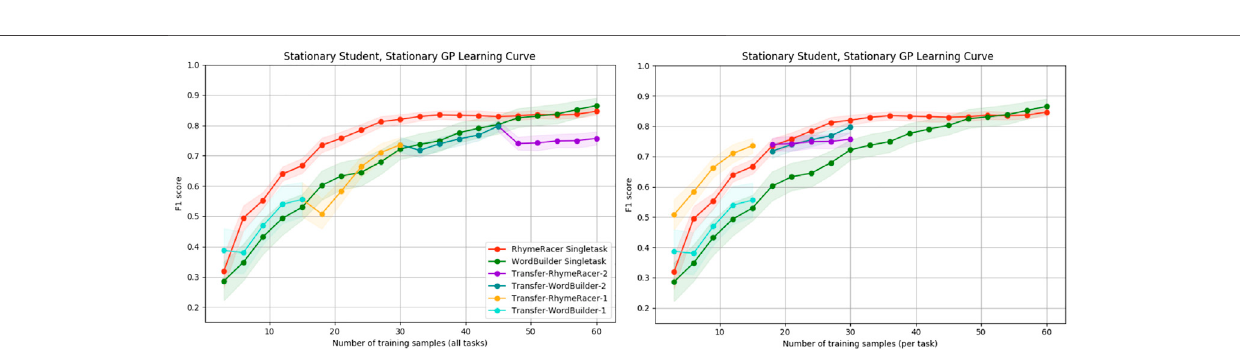
FIGURE 7 | Simple “ Pro fi ciency ” and “ Ef fi ciency ” evaluation of multi-task vs. single-task personalized models when WordBuilder is the fi rst task. The general trend is consistent with the results when RhymeRacer is fi rst, indicating that the results are stable independent of task order.